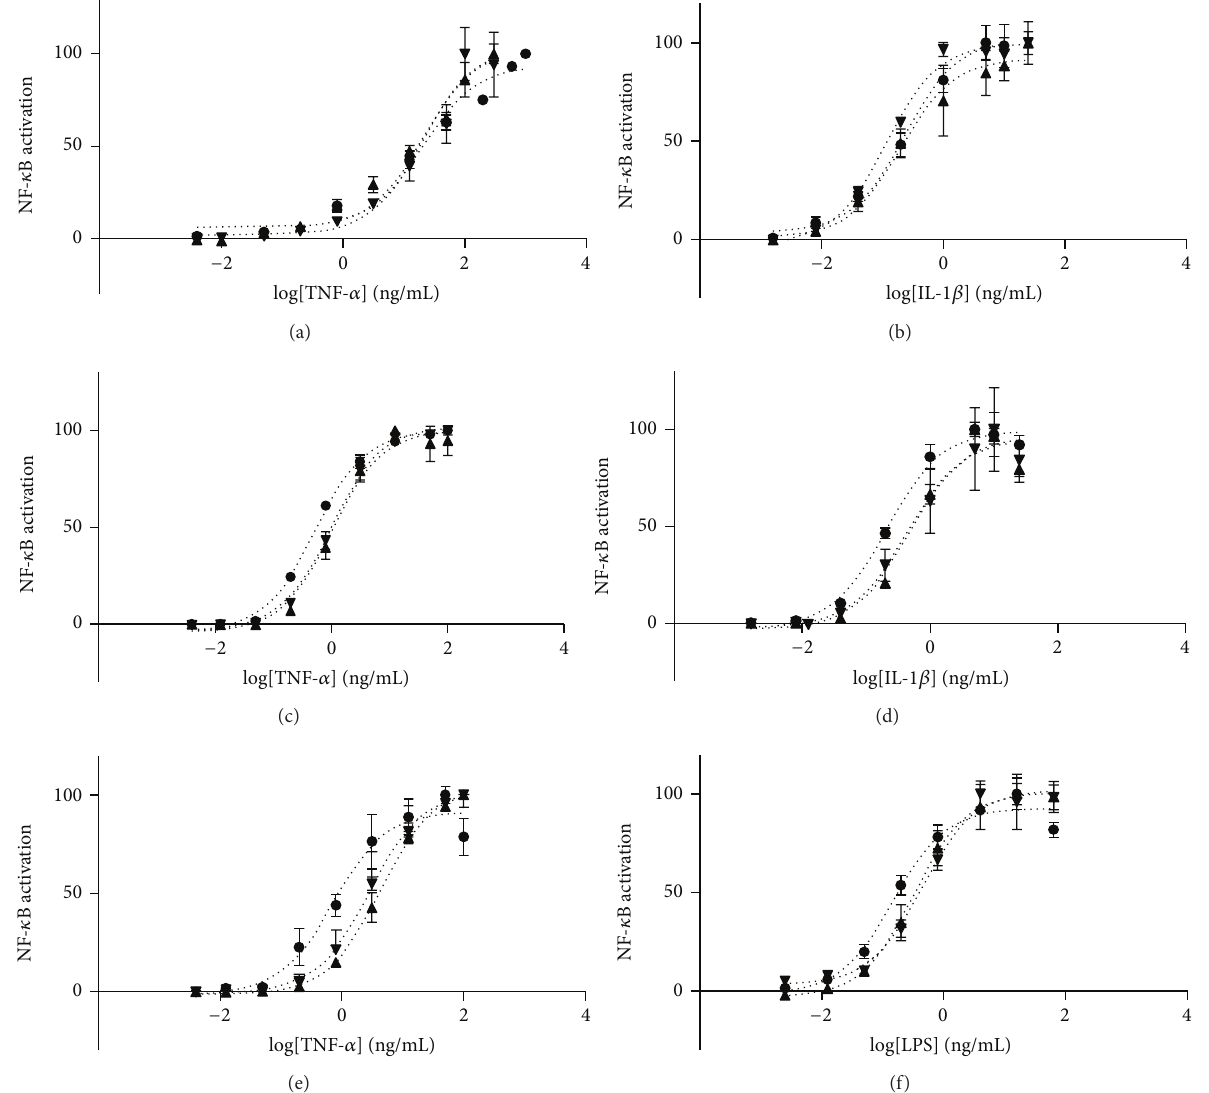
Figure 4: NF- 𝜅 B activation stability with passage number for different clones. Cells with 0 (black circle), 4 (downward triangle), or 8 (upward triangle) splitting passages of the reporter cell lines were seeded as follows: Caco-2-NF- 𝜅 B-hrGFP C3 clone ((a) and (b)) at 1 × 10 5 cell/well and HT-29-NF- 𝜅 B-hrGFP E5 clone ((c) and (d)) or F6 clone ((e) and (f)) at 5 × 10 4 cell/well. Cells were cultured ON and treated with TNF- 𝛼 , LPS, or IL-1 𝛽 . Cells were trypsinized and GFP expression was analyzed by flow cytometry. Data was normalized and fitted using nonlinear regression 3-parameter fit using GraphPad Prism. NF- 𝜅 B activation was determined as previously